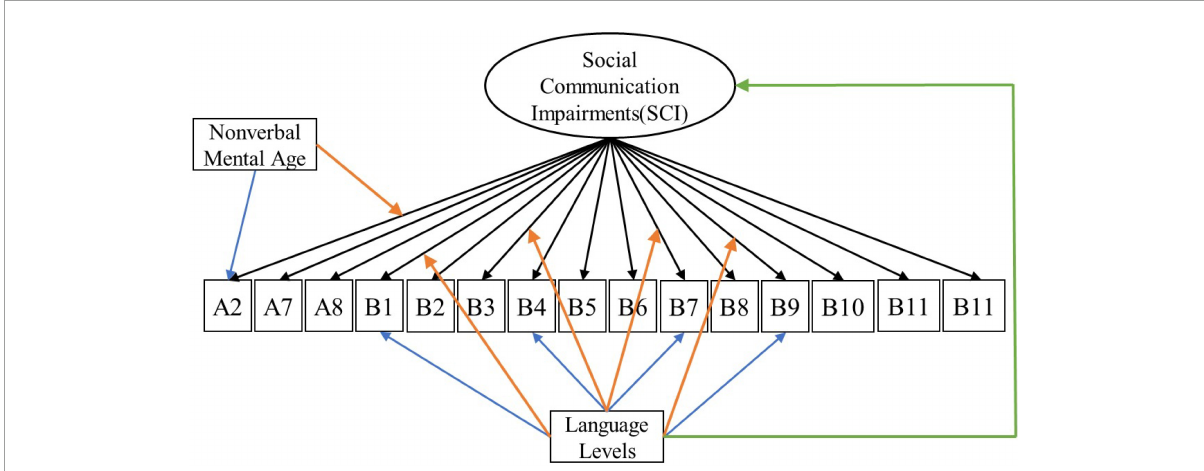
FIGURE1 Measurement model for social communication impairments (SCI). Black arrows indicate factor loadings of each item examined on the SCI latent construct. Colored Arrows in the figure showing significant impact of the covariate on the factor and item parameters: (1) Green arrow represents the impact of language level on the mean of the latent construct; (2) Orange arrows represent the impact of covariates (NVMA and language level groups) on the relationships between the item and the latent construct (non-uniform DIF); (3) Blue arrows represent the impact of covariates on the levels of items when the overall level of the latent construct is similar across groups (uniform DIF). For specific item names, please refer to Table 2 .